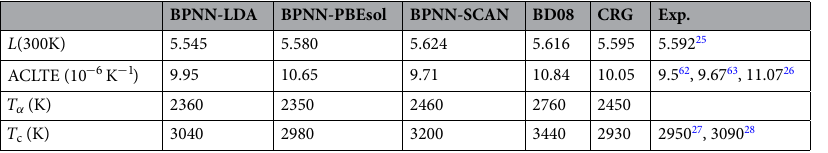
Table 3. The lattice constant L ( T ) at 300 K, the averaged coefficient of linear thermal expansion (ACLTE), the onset temperature of heat capacity anomaly T α , and the (cid:31) -peak temperature T c are